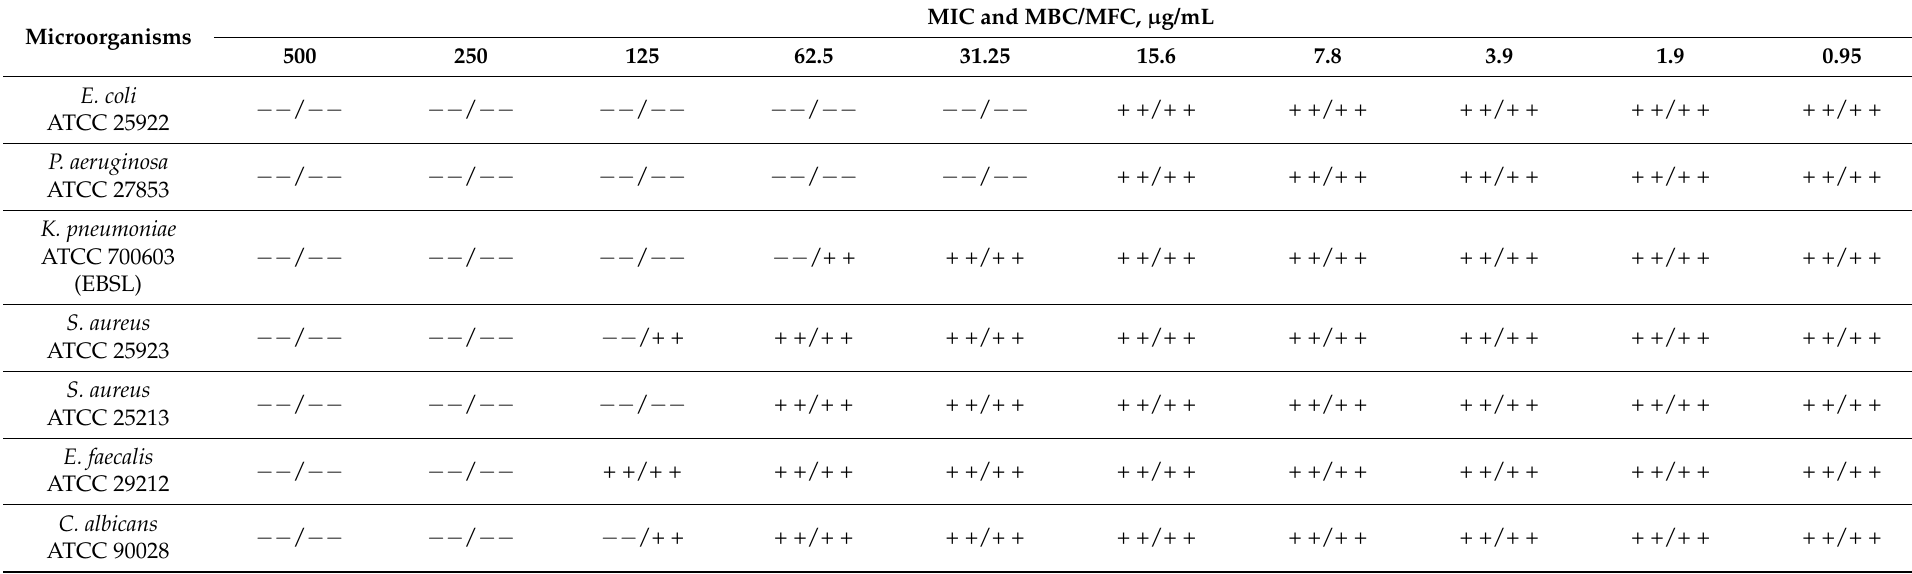
Table 2. Antimicrobial activity of one-year-stored PAAg water